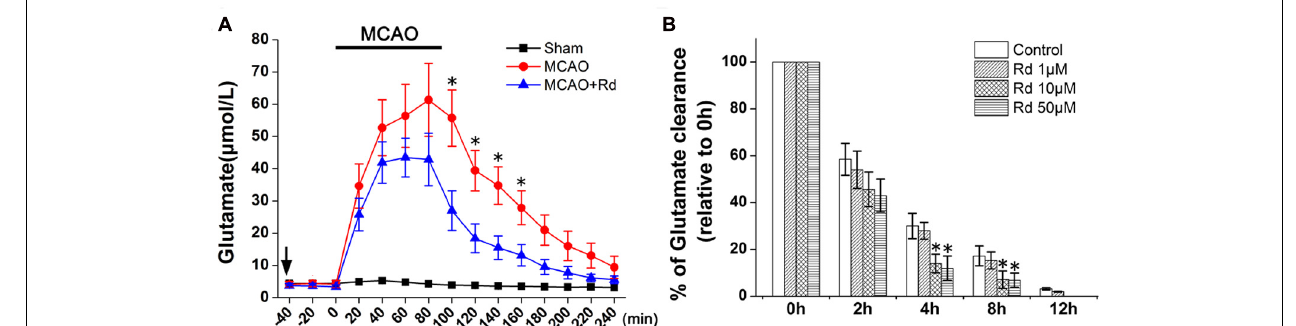
FIGURE 1 | Effect of Rd treatment on the extracellular concentrations of glutamate (A) Time course of the glutamate concentration determined with microdialysis in MCAO rats ( n = 6), MACO rats pre-treated with Rd (depicted as black arrow, 30 mg/kg, n = 8) or sham-operated rats ( n = 7) subjected to 90-min MCAO (depicted as the black bar) followed by 150-min reperfusion. Values are the means ± SEM. * p < 0.05 vs. MCAO + Rd group. (B) Glutamate